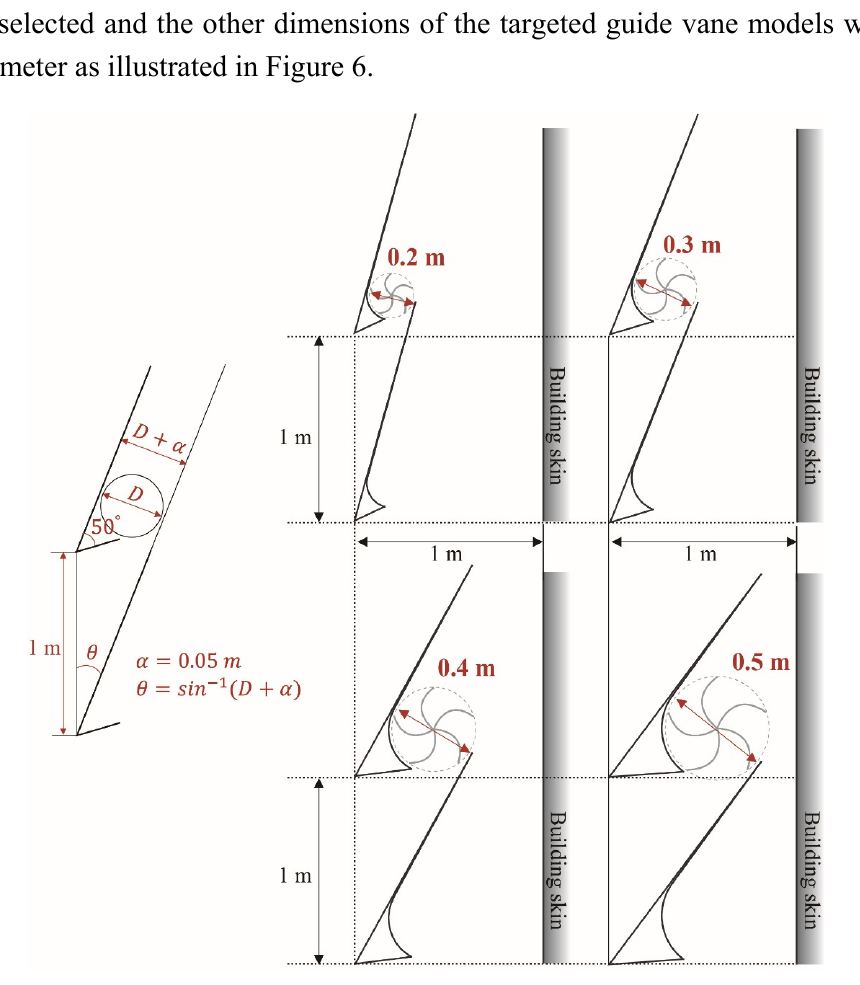
Figure 6. Design issues for the dimensions of the guide